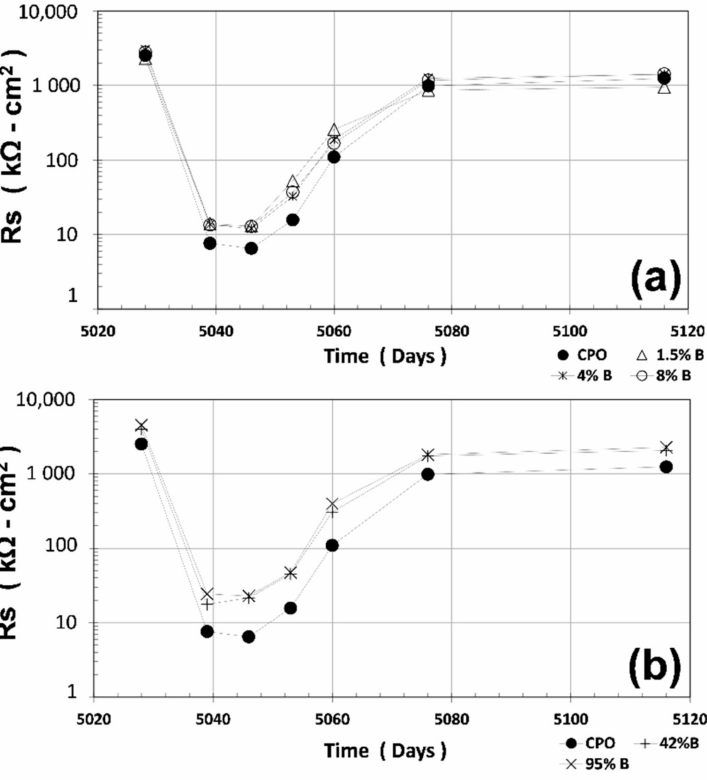
Figure 3. Average mortar electrical resistance (R S ) vs. time: ( a ) control vs. low OFI mucilage concentration; ( b ) control vs. high OFI mucilage